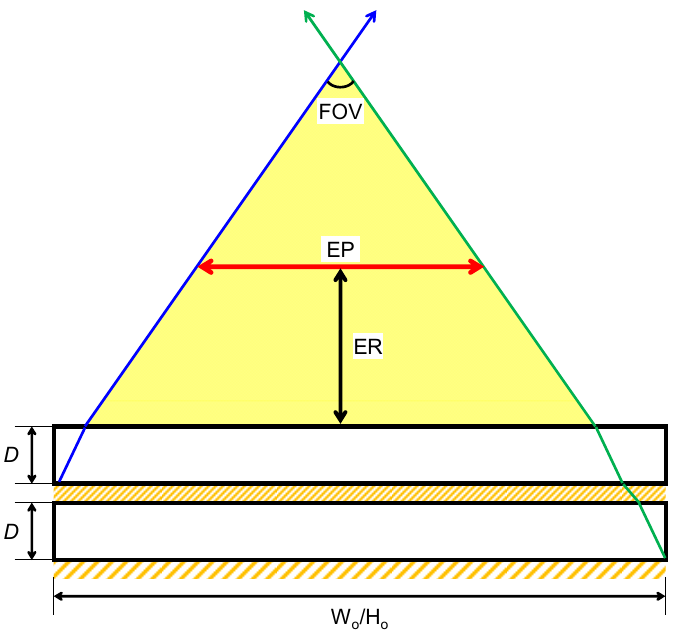
Figure 5. Geometric relationship among the FOV, eye relief and exit pupil. For FOV = 72° (horizontal) × 45° (vertical) and ER = 10 mm, EP = 4 × 3 mm 2 .